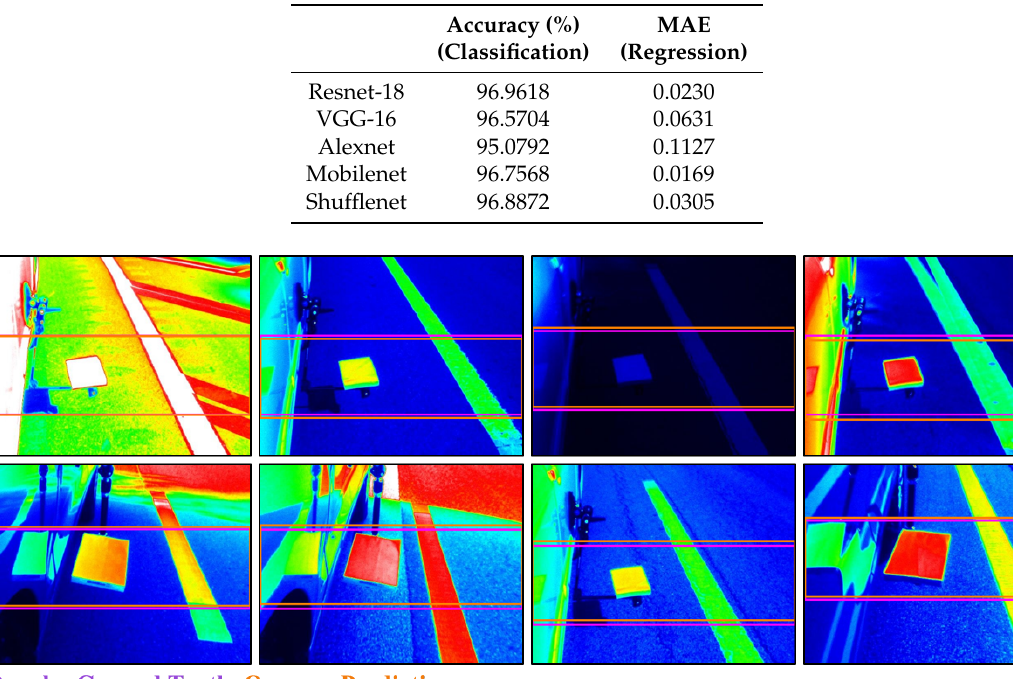
Figure 7. Comparative analysis for the Resnet-18 model h prediction result and ground